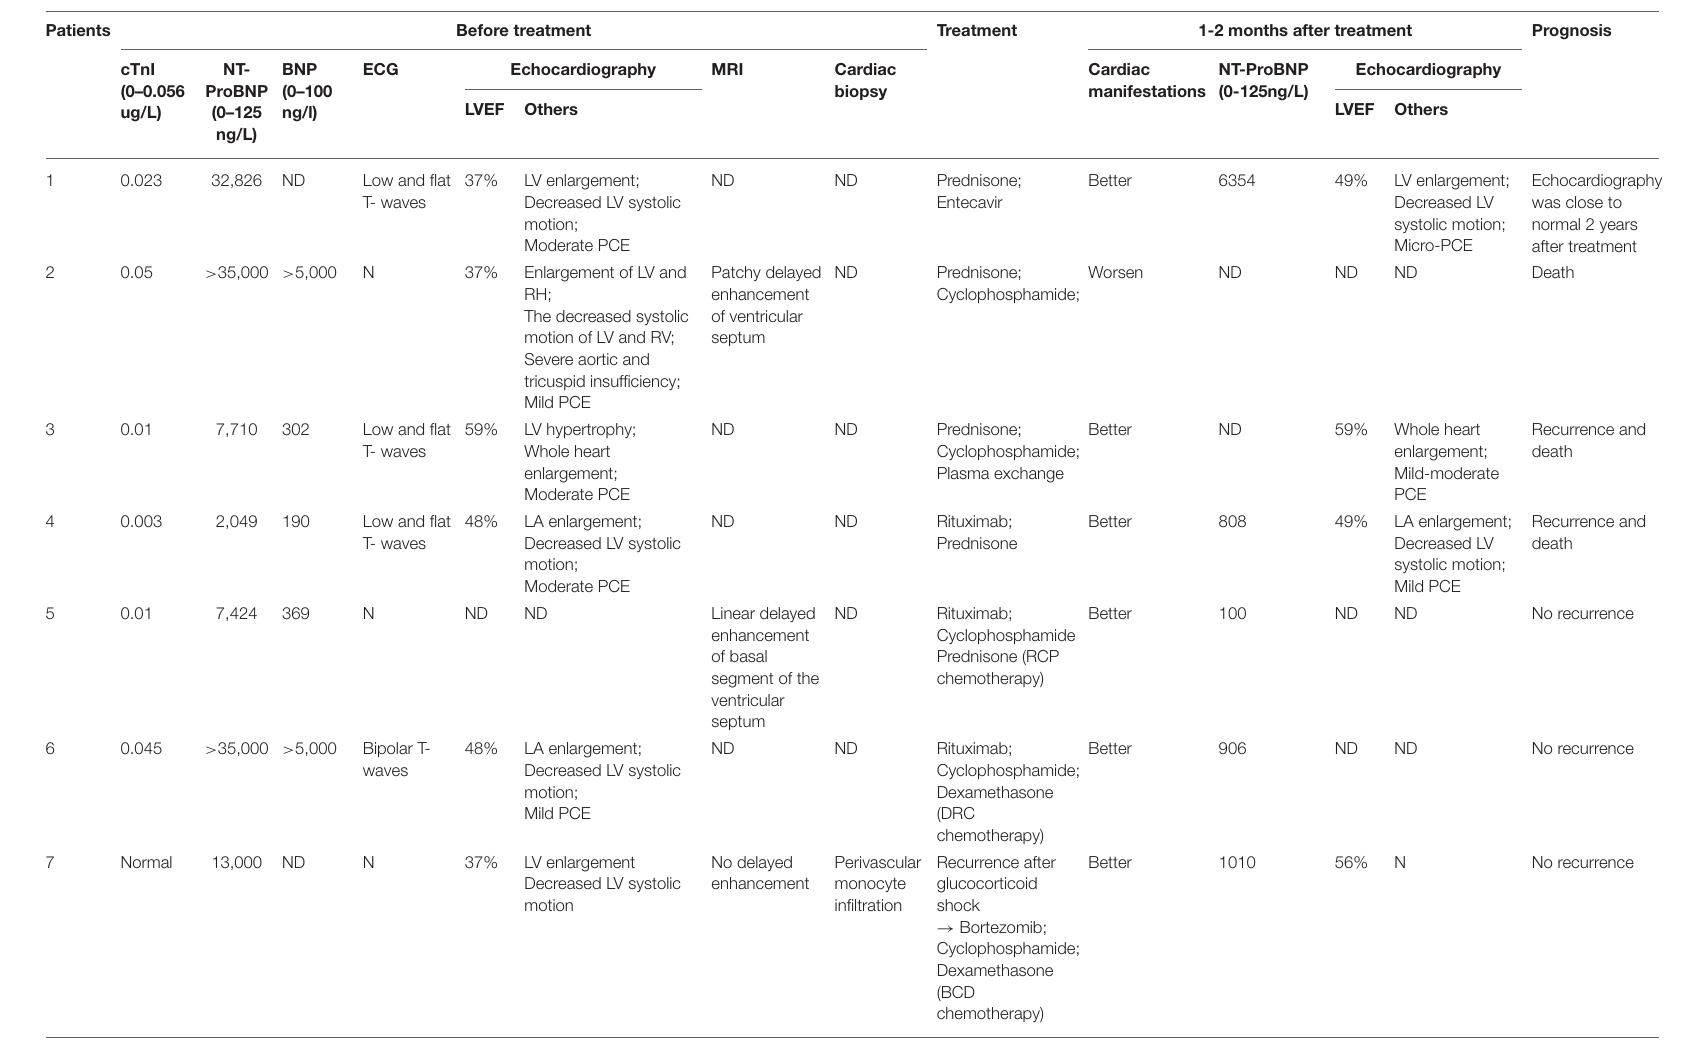
TABLE 2 | Cardiac related manifestations, treatment, and prognosis in 7 patients with cryoglobulinemia.